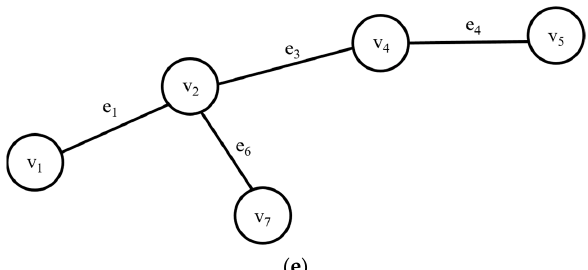
Figure 2. Subgraph query: ( a ) Q 1 ; ( b ) Q 2 ; ( c ) Q 3 ; ( d ) Q 4 ; ( e ) Q 5 .